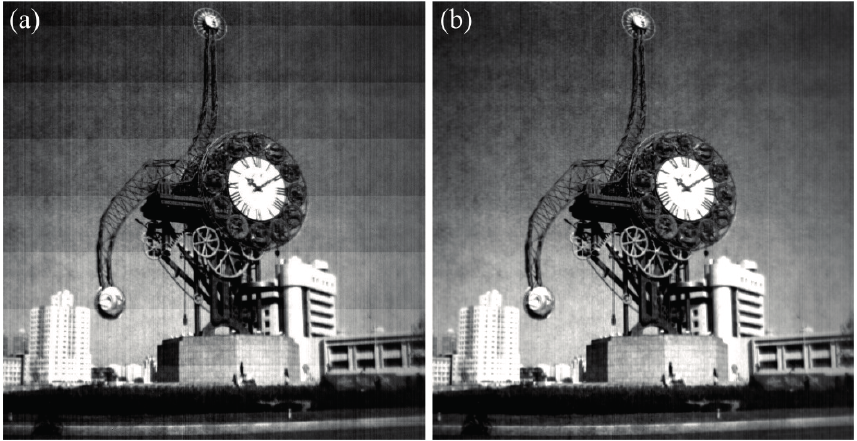
Figure 18. Comparison of visual effect of the Century Clock of Tianjin. ( a ) Original image; ( b ) Corrected